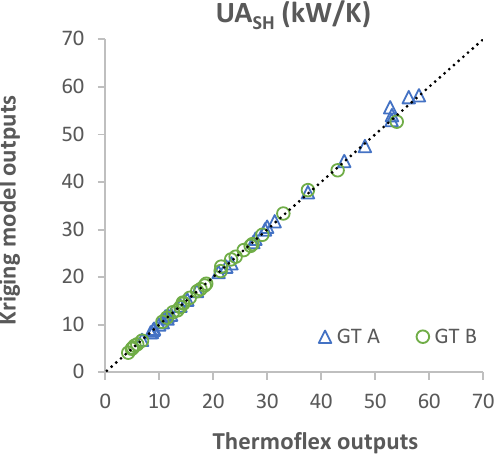
Figure A2. Parity plot of steam flow rate for Kriging model validation.